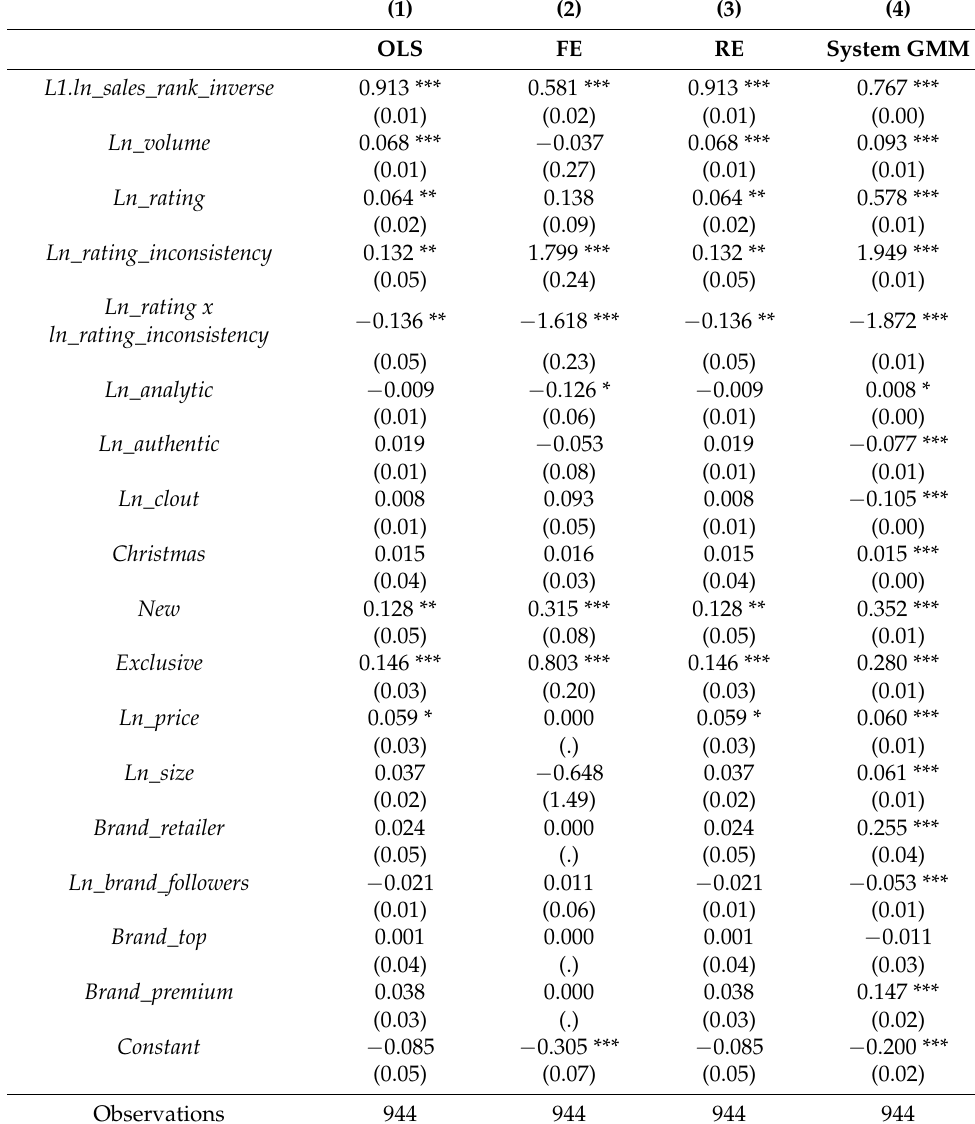
Table A2. Most helpful visibility—five most helpful reviews are viewed (case v 2.2 ).